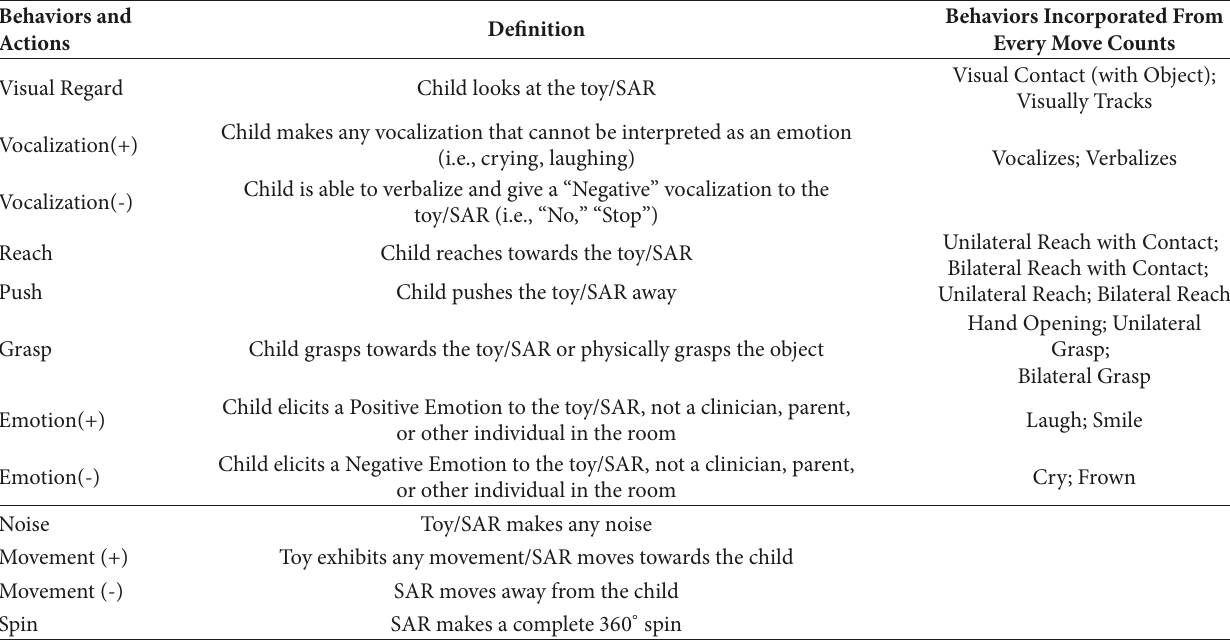
Table 3: Definitions of coded behaviors and actions for child and